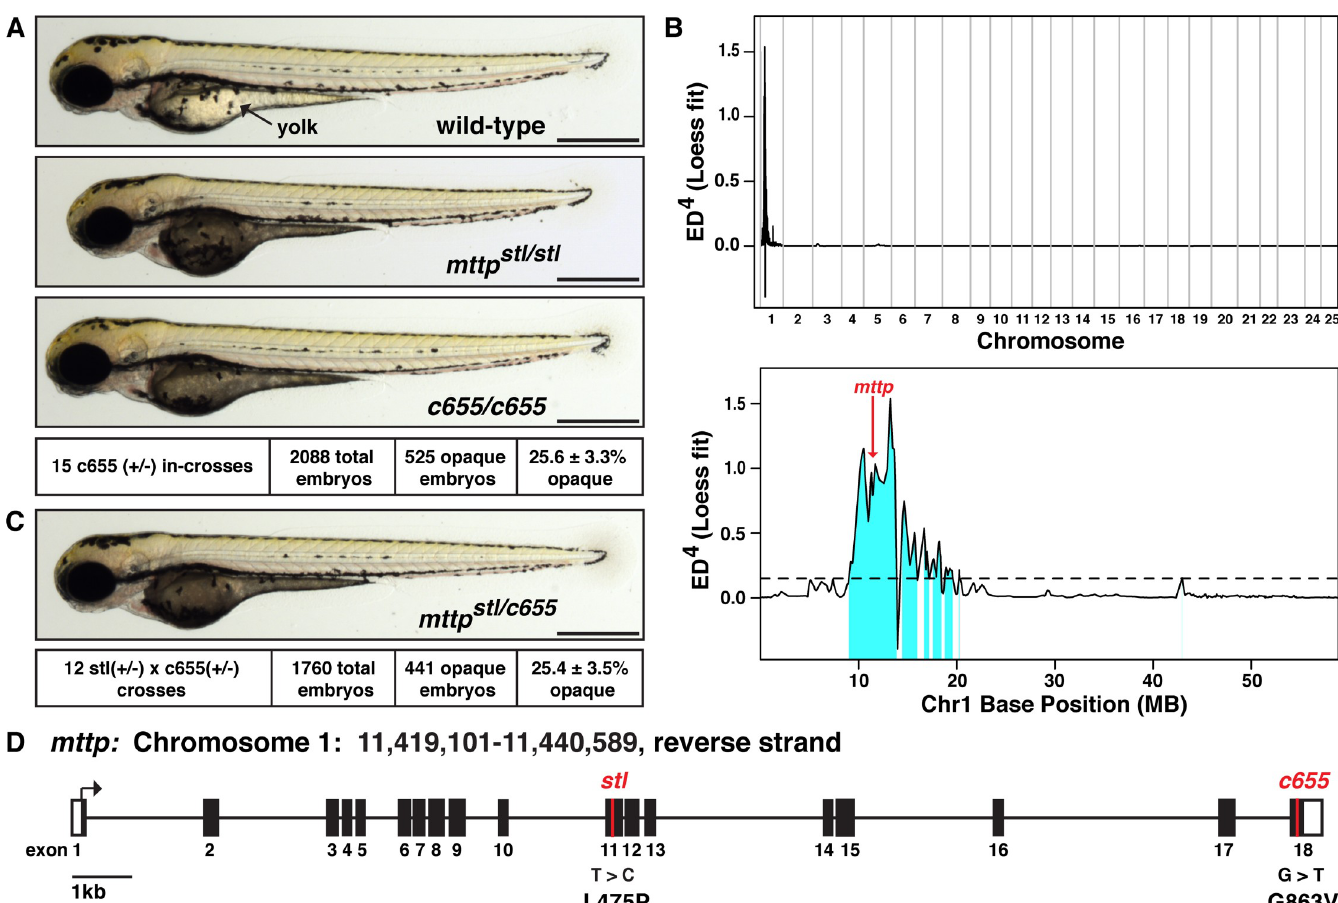
Fig 1. The c655 allele is a missense mutation in the M-subunit of microsomal triglyceride transfer protein. (A) Representative images of a wild-type zebrafish embryo, a homozygous mutant embryo carrying the previously described stalactite ( stl ) missense mutation in mttp , and a homozygous c655 mutant embryo at 3 days post fertilization (dpf); Scale = 500 μ m. The dark/opaque yolk phenotype in embryos from c655 heterozygous in-crosses segregated with a Mendelian ratio consistent with a homozygous recessive mutation, mean +/- SD. For source data, see S4 File. (B) Euclidean distance mapping analysis plots produced by MMAPPR [51], showing the likely genomic region of the c655 mutation. Plot of the LOESS fit to the mapping scores (Euclidean Distance 4 ) across all 25 chromosomes (top) and expanded view of chromosome 1(GRCz10: CM002885.1) (bottom). Single nucleotide variants (SNVs) present in this 11 MB region in c655 mutant embryos were assessed for their effect on annotated genes using the Ensembl Variant Effect Predictor [52], including using the Sorting Intolerant from Tolerant algorithm (SIFT) [53], to predict the impact of changes on protein-coding sequence (tolerated or deleterious). We extracted variants that alter the protein-coding sequence as candidates for the causal mutation (223 variants in 64 genes, of which 42 are missense variants predicted to be deleterious; S1 File). One of the SNVs linked to the c655 phenotype was a G > T missense mutation predicted to be deleterious in exon 18 of the microsomal triglyceride transfer protein gene (ENSDARG00000008637, Chr1:11,421,261 GRCz10, red arrow in B shows